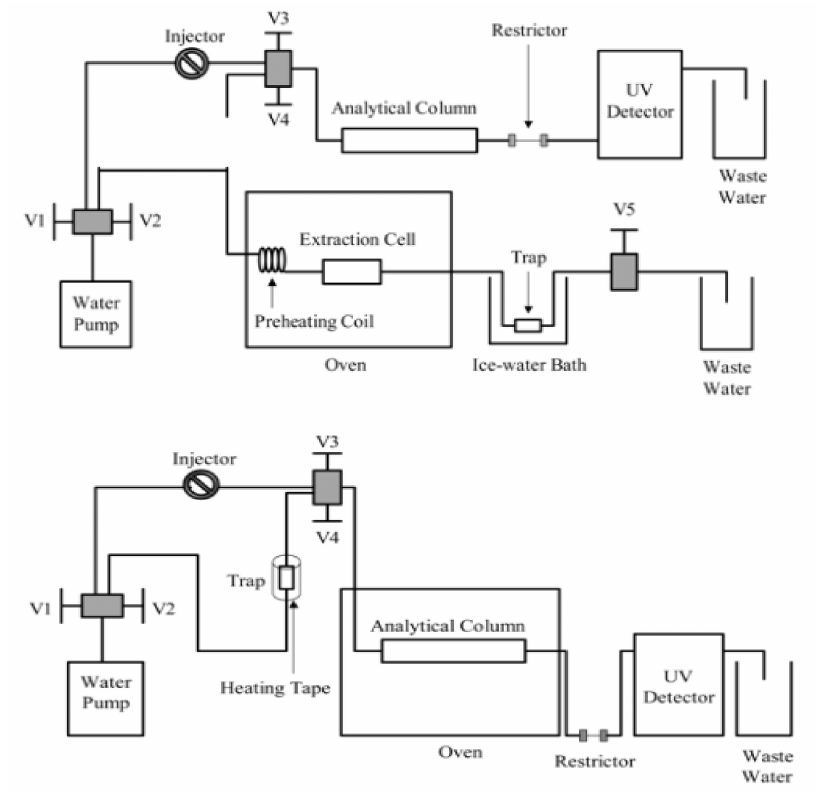
Figure 5. Offline coupling of SBWE with SBWC. Adapted with permission from [70] (Lamm, L.; Yang, Y. Off-line coupling of SBWE with subcritical water chromatography via a sorbent trap and thermal desorption. Anal. Chem . 2003 , 75 , 2237–2242.). Copyright 2003 American Chemical